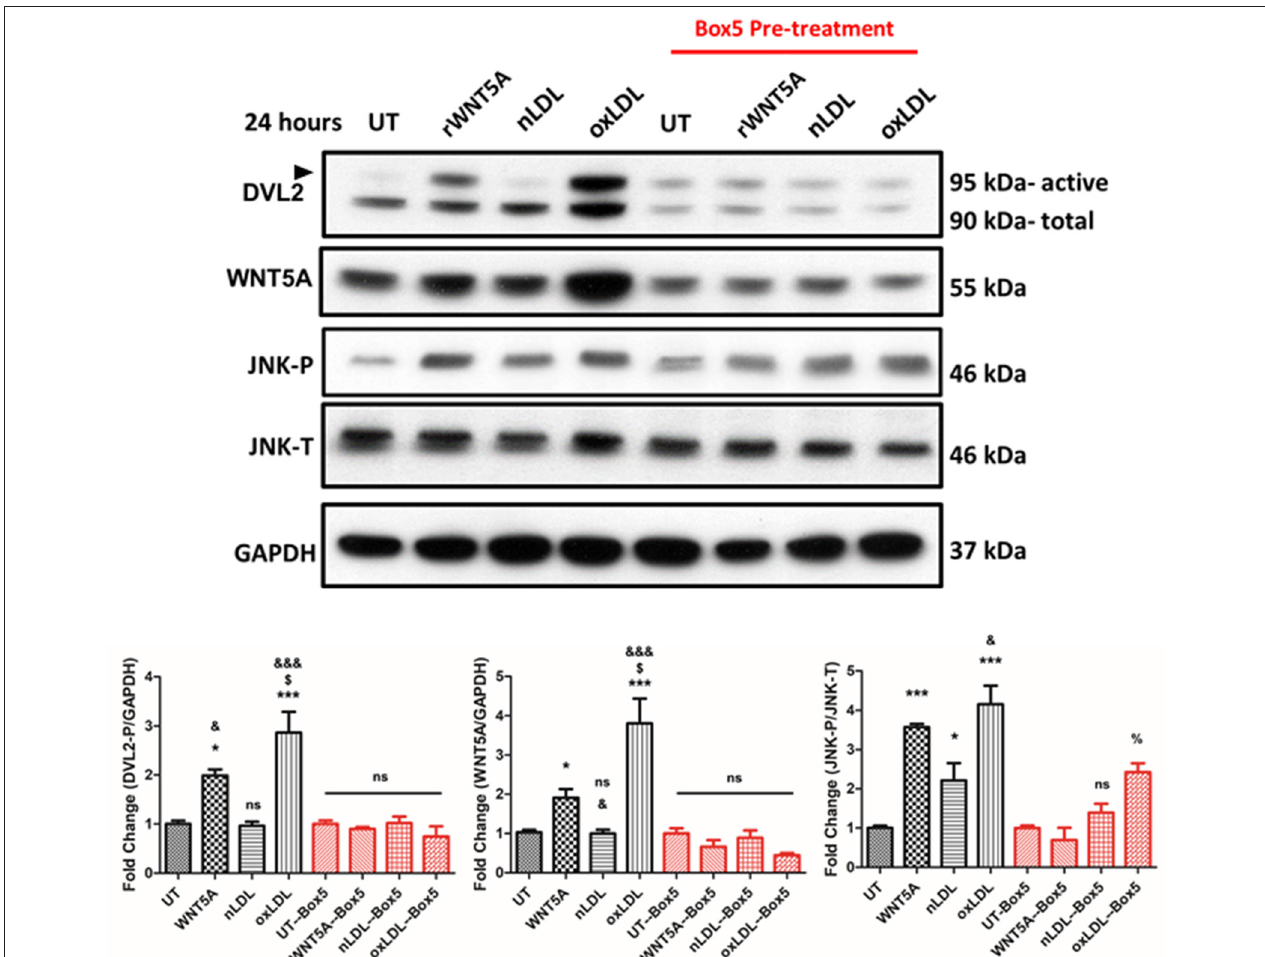
FIGURE 1 | Box5 Blocks rWNT5A and oxLDL-Mediated Non-canonical Wnt Signaling in THP-1-Derived Macrophages. Representative western blots of THP-1-derived macrophages. THP-1-derived macrophages were pre-treated, or not, with Box5 (100mM) for 1h or not followed by treatment with rWNT5A (100ng/mL), nLDL, or oxLDL (both 100 µ g/mL) for an additional 24h. Box5 significantly inhibited rWNT5A-induced and oxLDL-induced DVL2 activation (black arrow). Box5 also inhibited rWNT5A-induced JNK activation but not oxLDL-induced JNK activation, although overall activation was reduced. Experiments were performed in triplicate and western blot band intensities were quantified and are presented as bar graphs (mean ± SEM) of the ratios of DVL2-p/GAPDH, WNT5A/GAPDH, JNK-P/JNK-T expression relative to respective controls (UT or UT-Box5). ns = not significant compared to untreated control (UT or UT-Box5) ( p > 0.05); * = compared to UT control ( p < 0.05); *** = compared to UT control ( p < 0.001); % = compared to Box5 UT control ( p < 0.05); & = compared to nLDL control ( p < 0.05); &&& = compared to nLDL control ( p < 0.001). $ = compared to rWNT5A ( p <